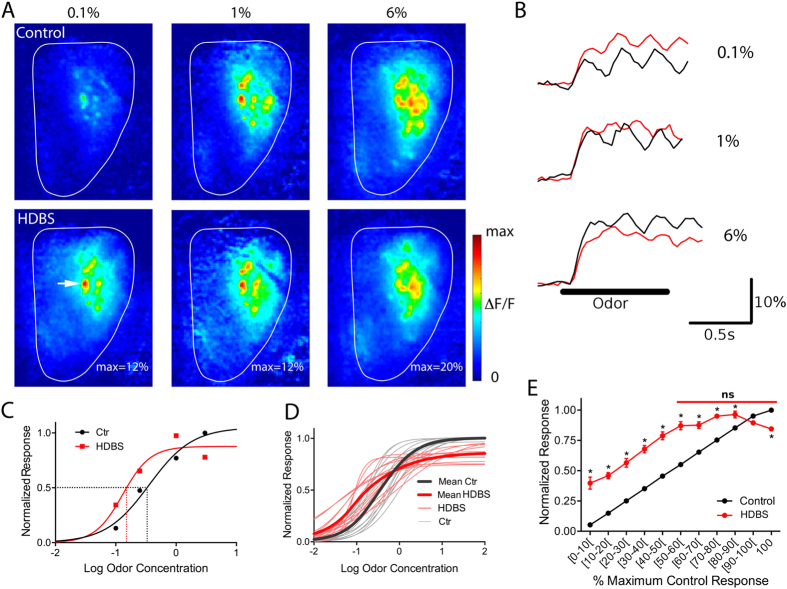
HDBS bidirectionally modulates glomerular odor responses.(A) Responses to increasing concentrations of methyl valerate in control (top) and HDBS (bottom) conditions. Glomerular odor responses are increased by HDBS for the low and middle range concentrations while they are decreased at the highest concentration. (B) Fluorescence signal traces for the glomerulus indicated by arrow in A. Response intensity is increased for the low and middle range concentration while it is decreased for the high concentration. (C) Example of a sigmoid fit of Log odor concentration (Log 1% = 0) - normalized odor responses curves for a single glomerulus in control and HDBS conditions. HDBS shifts the curve to the left resulting on decreasing the EC50 (dashed line) and decreases the maximum response. (D) Sigmoid fit of Log odor concentration – normalized odor responses of all the glomeruli shown in A, the thick lines show the average curves in both control (black) and HDBS (red) conditions. The grey and red curves are individual curves of each responsive glomerulus. (E) Population normalized control and HDBS curves, plotted as function of the normalized control responses divided into 10% intervals. The curves show that odor responses are increased by HDBS from the lowest concentration to 80%, the HDBS curve crosses the control curve in the [80–90%] interval and the highest responses are significantly decreased after HDBS. (Mean ± SEM, *: p < 0.01). Red bar: HDBS responses are not significant from each other within the [50–100%] interval.